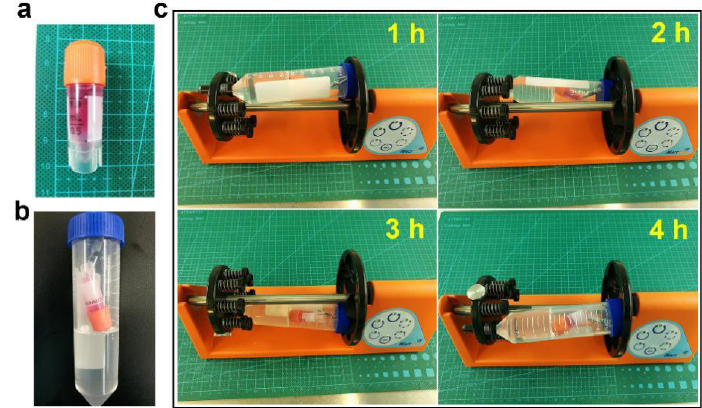
Figure 10. Schematic illustration of the three-layered arteriovenous structure and its transverse and longitudinal sectional view. (Scale bar: 5 mm).